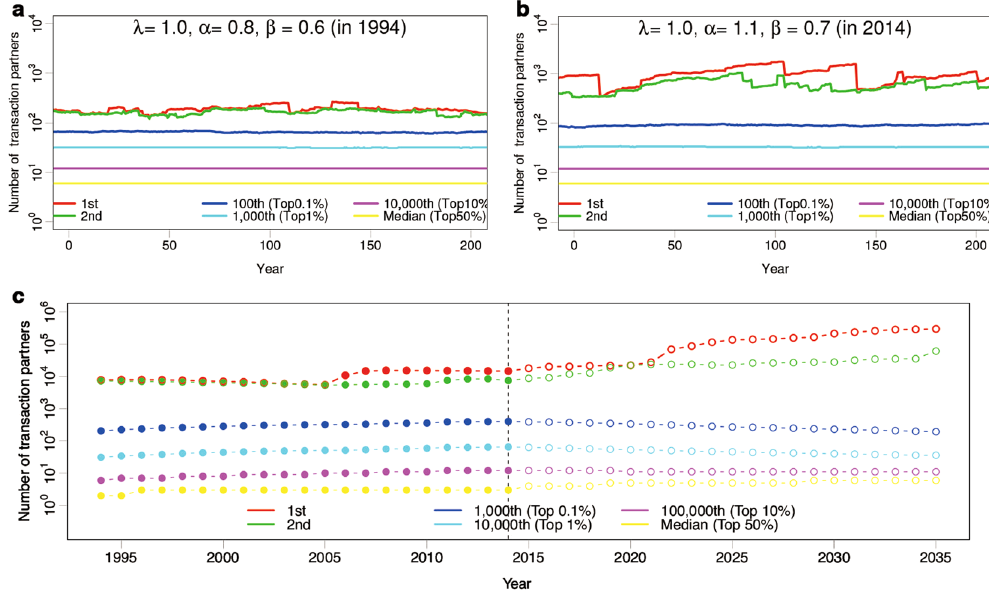
Figure 3. Simulated time evolution of number of transaction partners. Each mark shows size of 1st (red), 2nd (green), top 0.1% (blue), top 1% (light blue), top 10% (violet) and top 50% (yellow) in semilog plot. ( a , b ) Examples of simulated time series with initially N 0 = 100,000 firms using empirically observed parameter-sets ( λ , α , β ) for the years of 1994 and 2014, respectively. ( c ) Time series of Japanese inter-firm business transactions network from 1994 to 2014, and simulated time evolution of that from 2015 to 2035 using the parameter-set of